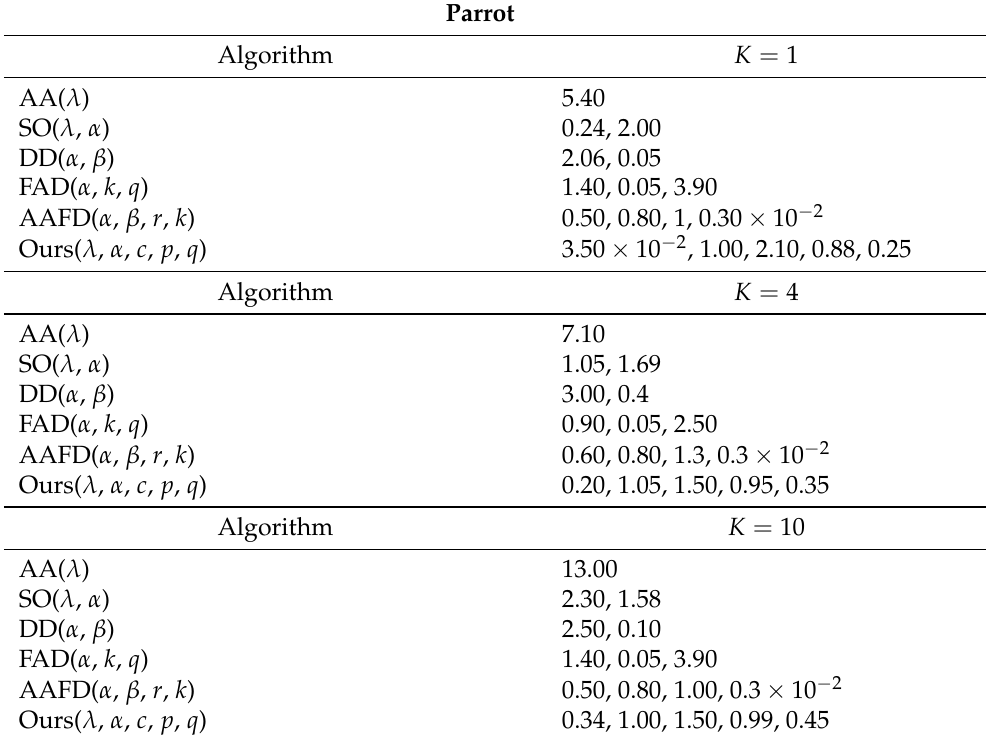
Table 1. The parameter values for numerical experiments.